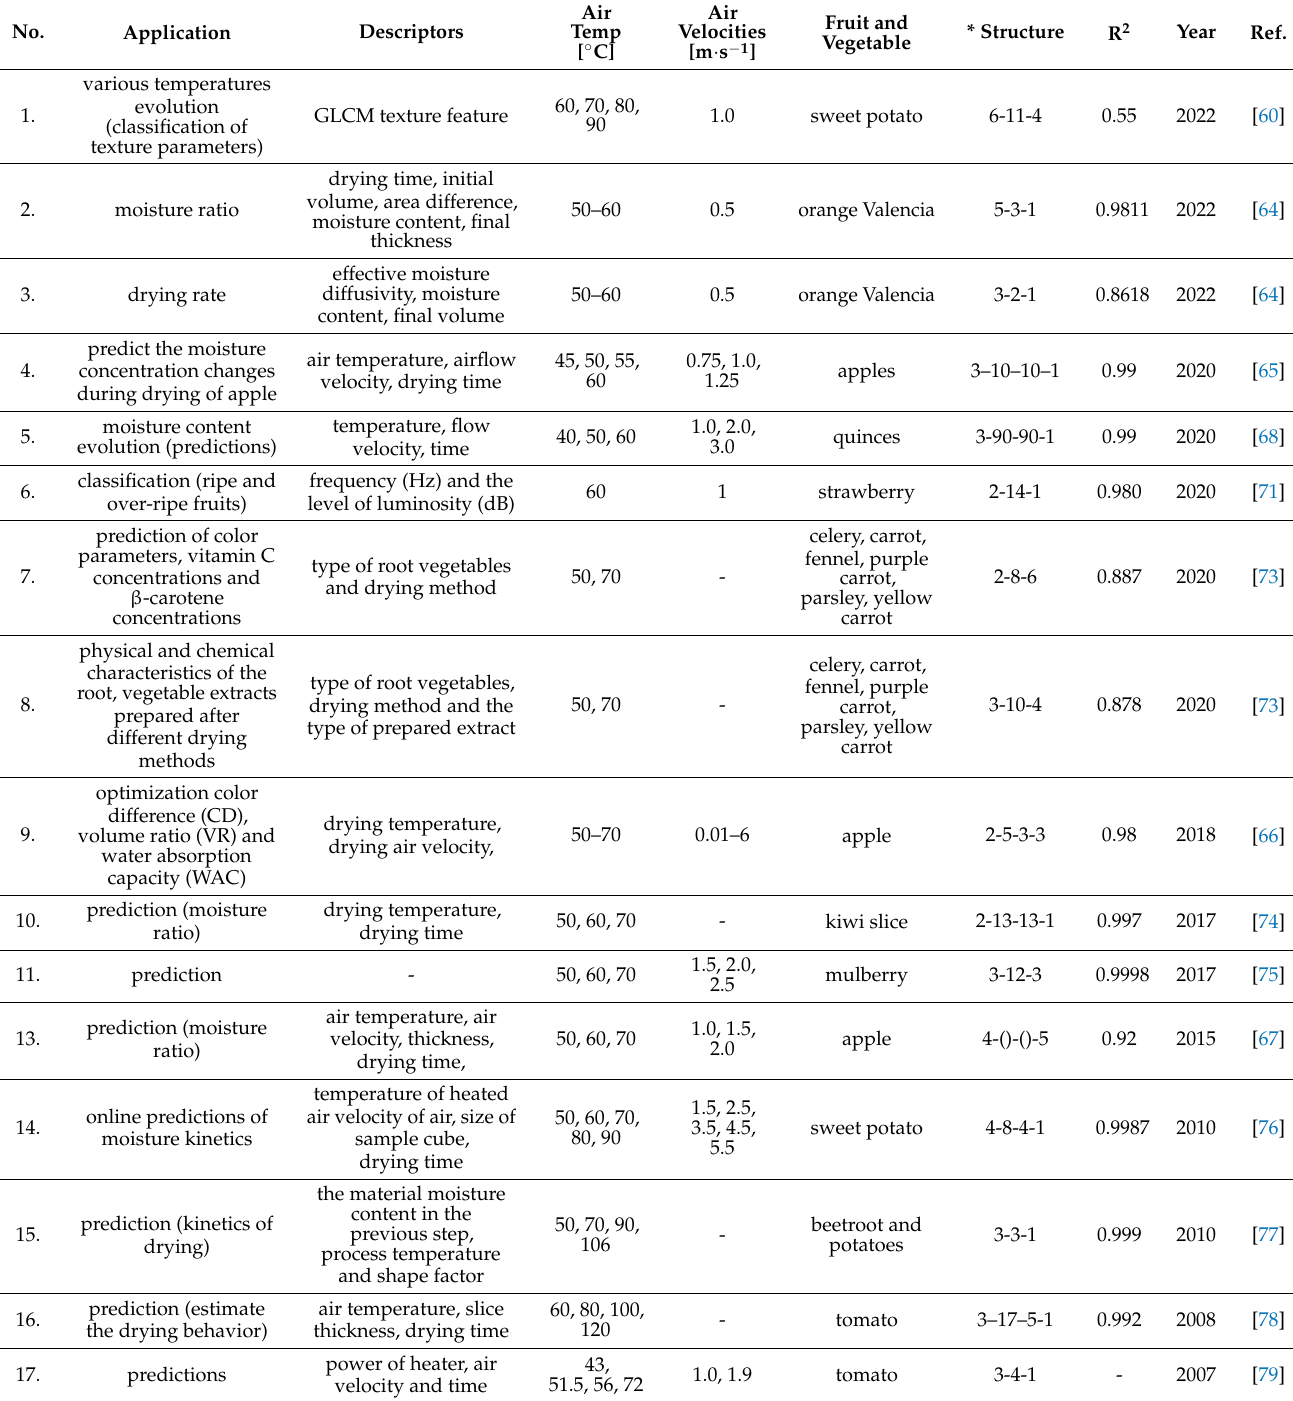
Table 1. Applications of multi-layer perceptron by using convective drying from 2007 to